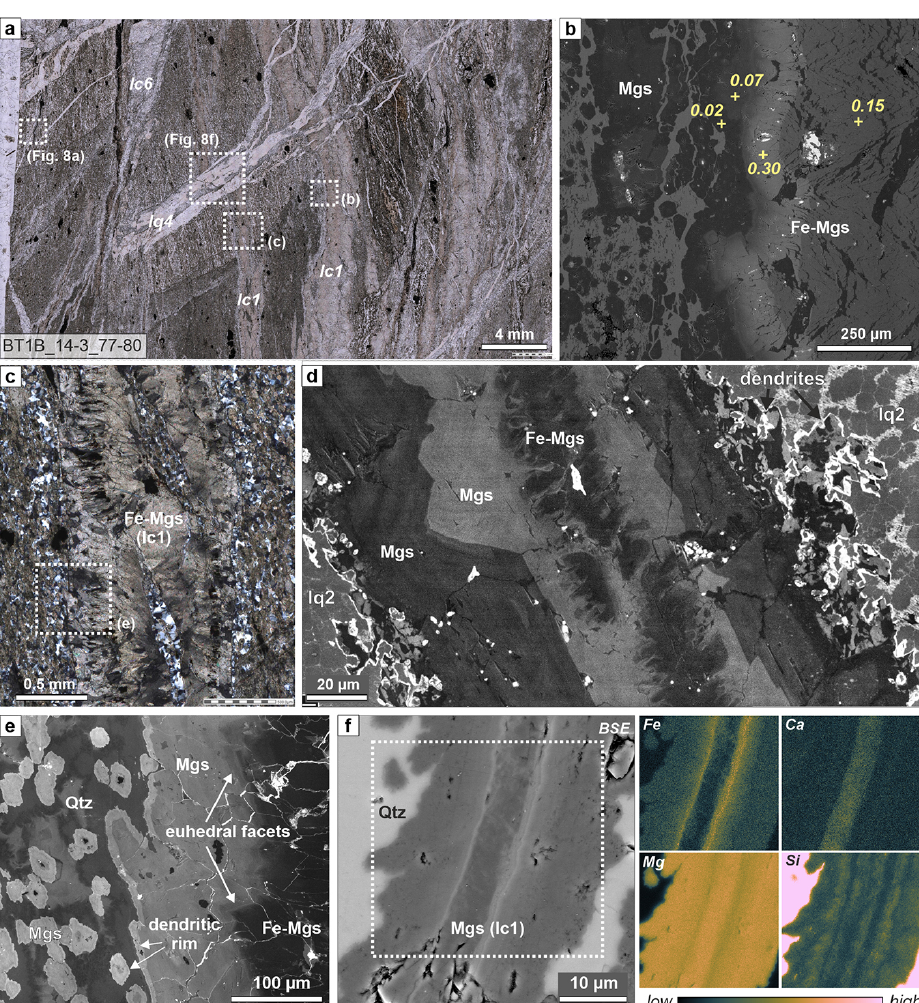
Figure 7. Zoned magnesite veins in listvenite. (a) Thin section overview of listvenite with comparatively wide, zoned Fe-magnesite veins (lc1), cut by a quartz–magnesite vein (lq3). (b) BSE image of a rim of a zoned magnesite vein, with Fe / (Fe + Mg) of magnesite shown for different zones (from EDX spot measurements). (c) Crossed polarized micrograph of a zoned magnesite vein with lens-shaped host listvenite inclusions. (d) Pan-chromatic SEM-CL image of an lc1 magnesite vein with an Fe-rich median zone, concentrically zoned growth with euhedral facets towards the vein walls, and dendritic boundaries with bright luminescent SiO 2 overgrowth. The matrix consists of microcrystalline quartz (lq2) (sample BT1B_67-2_36-40). (e) SEM-CL image of the area indicated in (c) , showing euhedral magnesite growth towards the vein walls. (a, b, c, e) Sample BT1B_14-3_77-80). (f) BSE image and EDX maps of the dotted area of a thin zoned magnesite vein in listvenite, showing systematic variations in the number of SiO 2 nano-inclusions that are apparent as variable Si-bearing magnesite at the resolution of EDX measurements (sample BT1B_27-2_6-8). Contrasts are adapted for each EDX map separately to improve visibility of